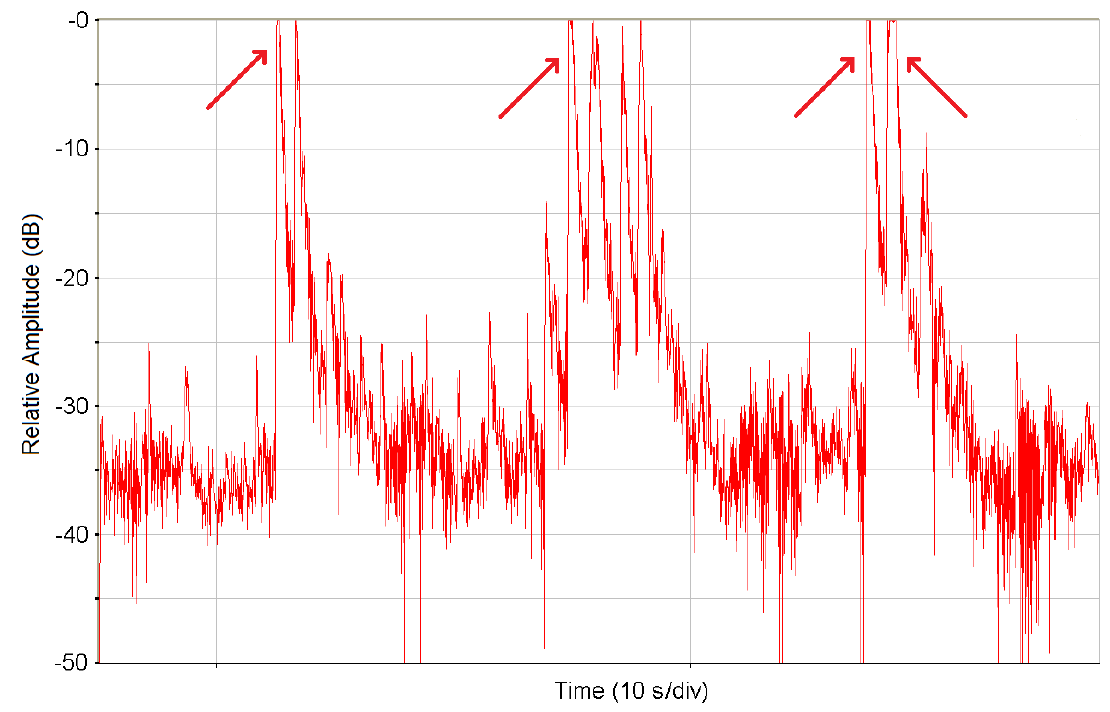
Figure 7. The logarithmic value of the linear amplitude value for each sampling point from the wave form data shows amplitude change over time in 0.5 m SWH (same time period as in Figure 1). Time (s) on the x -axis and relative amplitude (dB) on the y -axis. Clipped (distorted) signals are marked with red arrows.